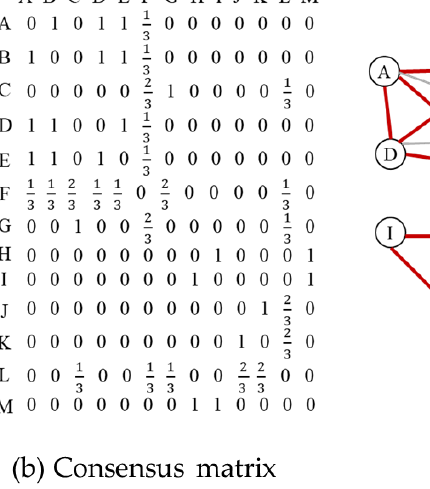
Figure 5. Construction of consensus matrix and consensus network: ( a ) three spatial community detection results; ( b ) consensus matrix; ( c ) consensus network.